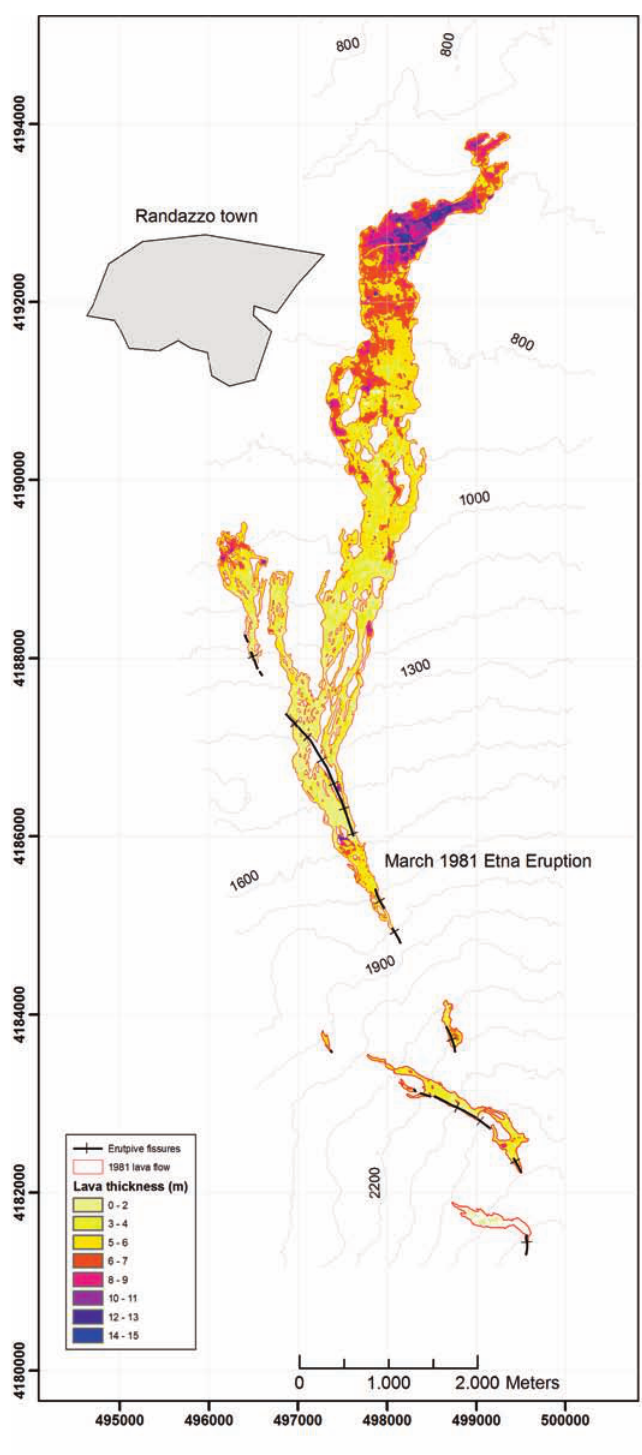
Figure 5. Lava flow thickness distribution and eruptive fissures of the 1981 Etna